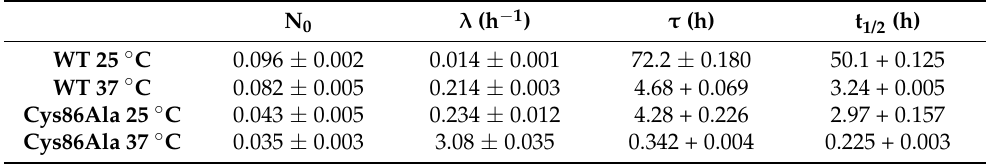
Table 1. Summary of autoxidation parameters for the WT and Cys86Ala using the exponential decay